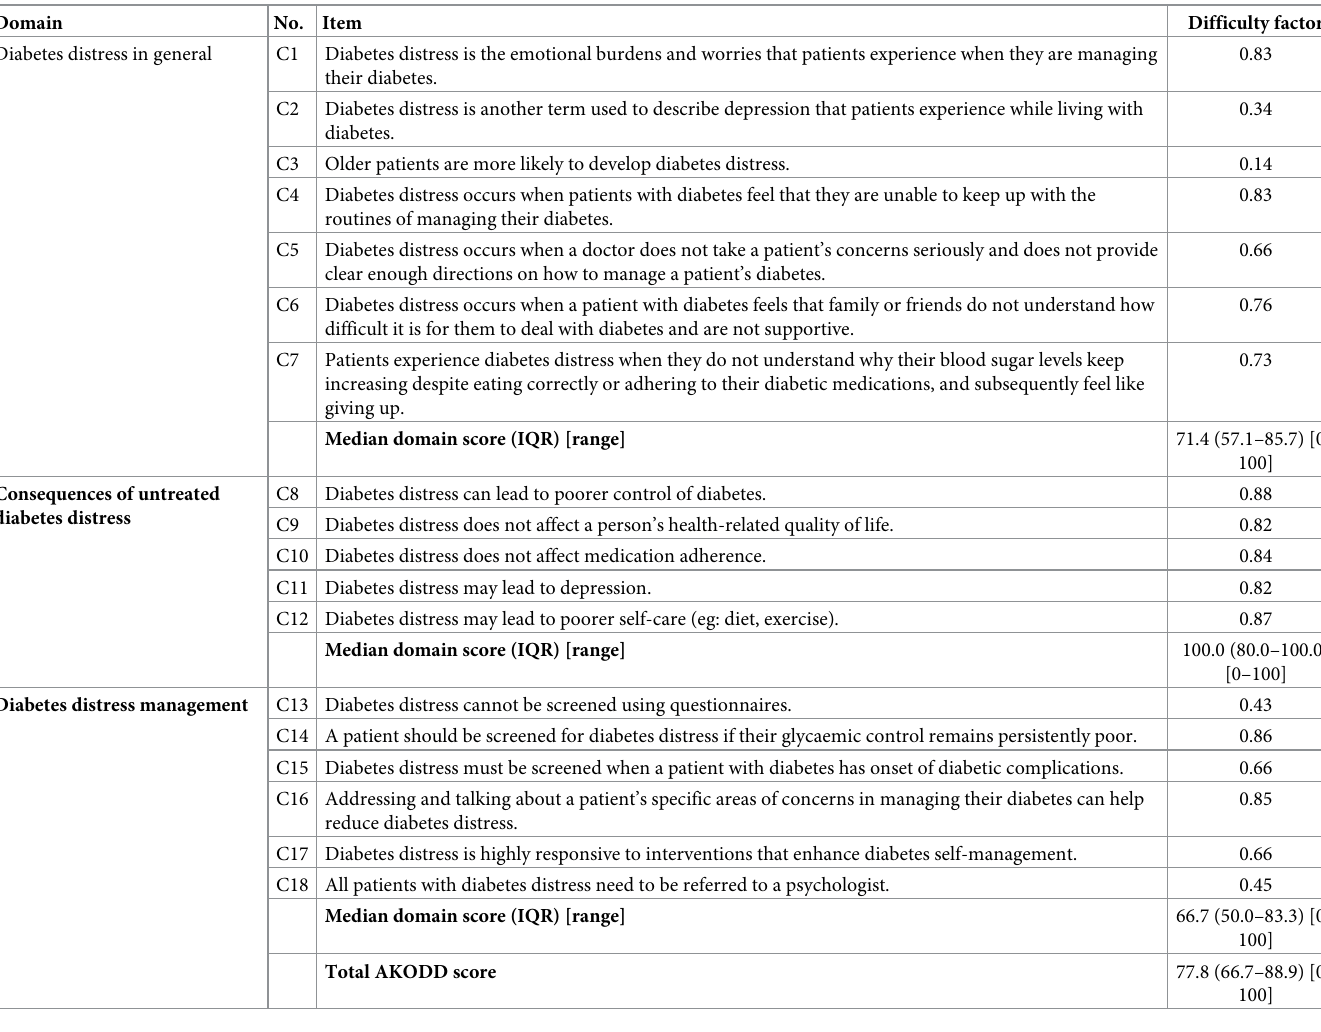
Table 2. Difficulty factor of each item in the awareness and knowledge of diabetes distress (AKODD) questionnaire.